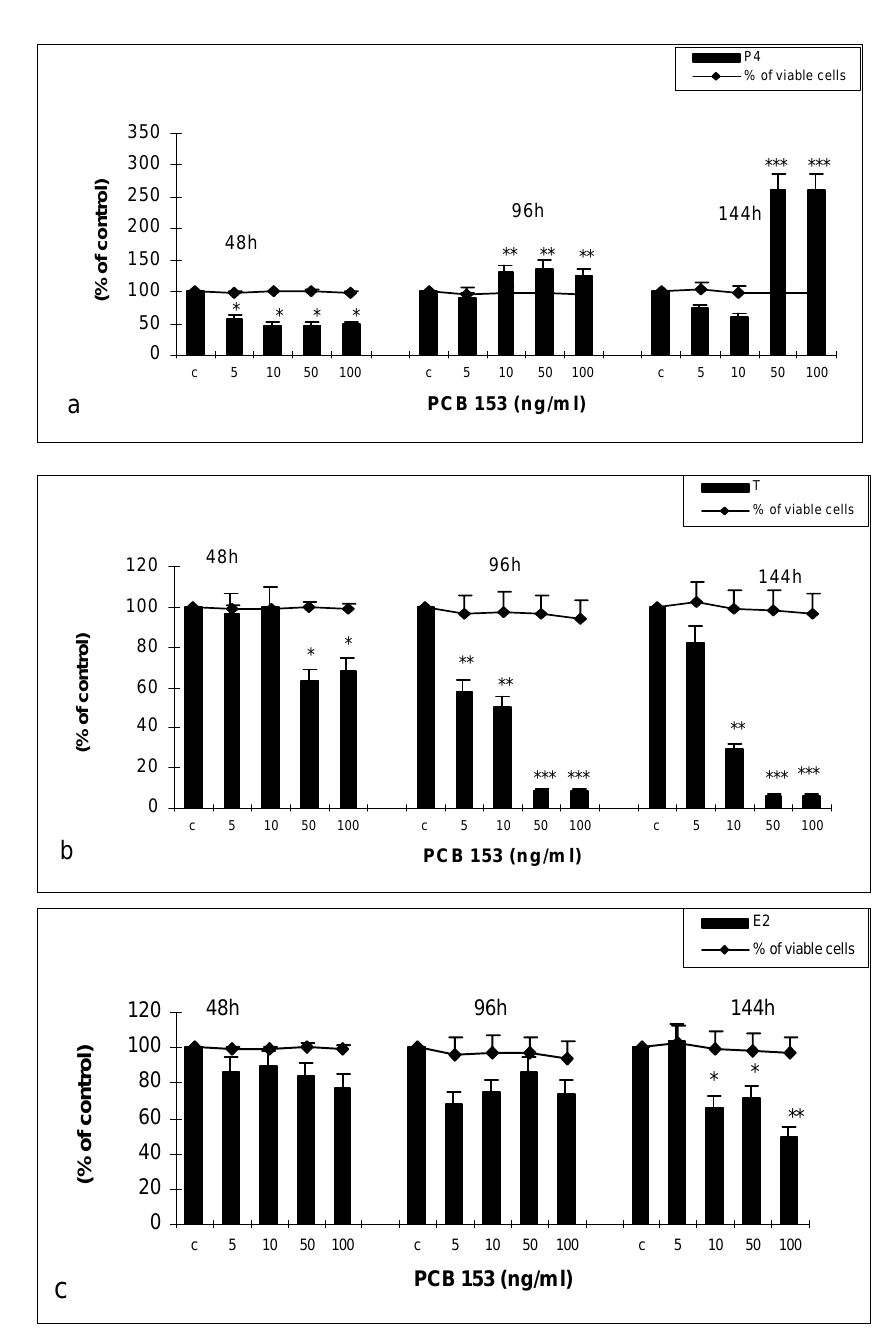
FIGURE 1. Dose-dependent effect of PCB 153 on follicular cell viability and steroids secretion: (a) P4, (b) T, and (c) E2. All values are the mean +/- SE and expressed as percent secretion with the control as 100*. * = <0.05; ** = p < 0.01; *** = p <